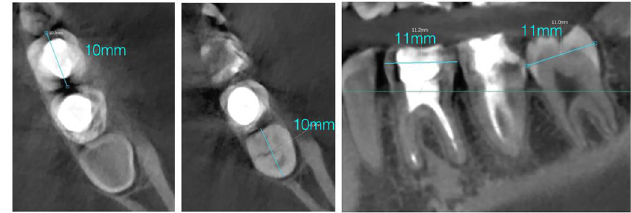
Fig. 1. Cone beam computed tomography sections and three- dimensional analysis of teeth 36